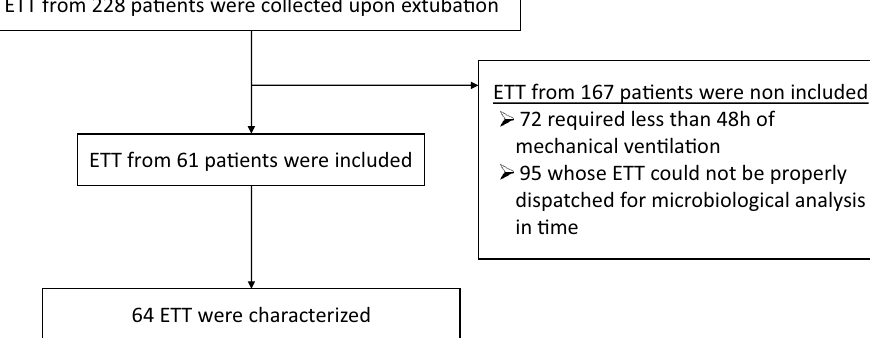
Figure 1. Flow chart for study screening and inclusion of ETT